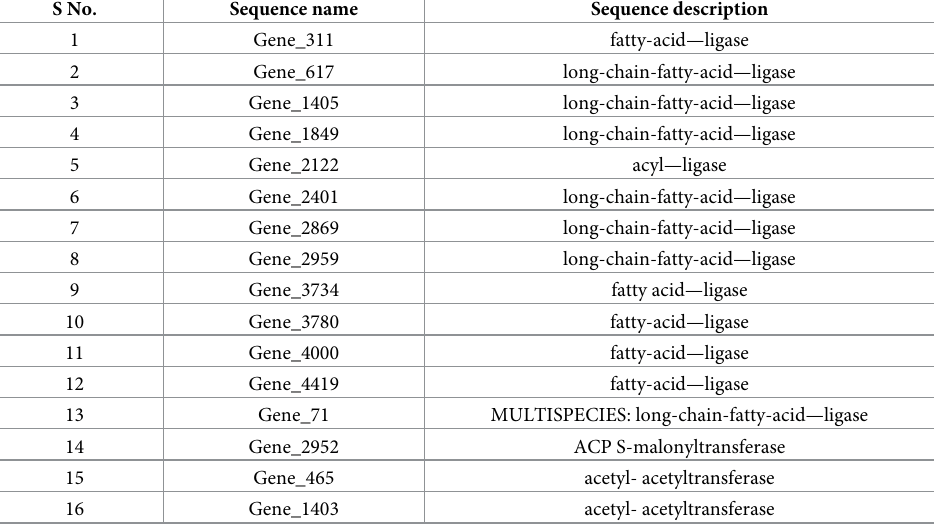
Table 2. Genes involved in biosynthesis of C18 fatty acid